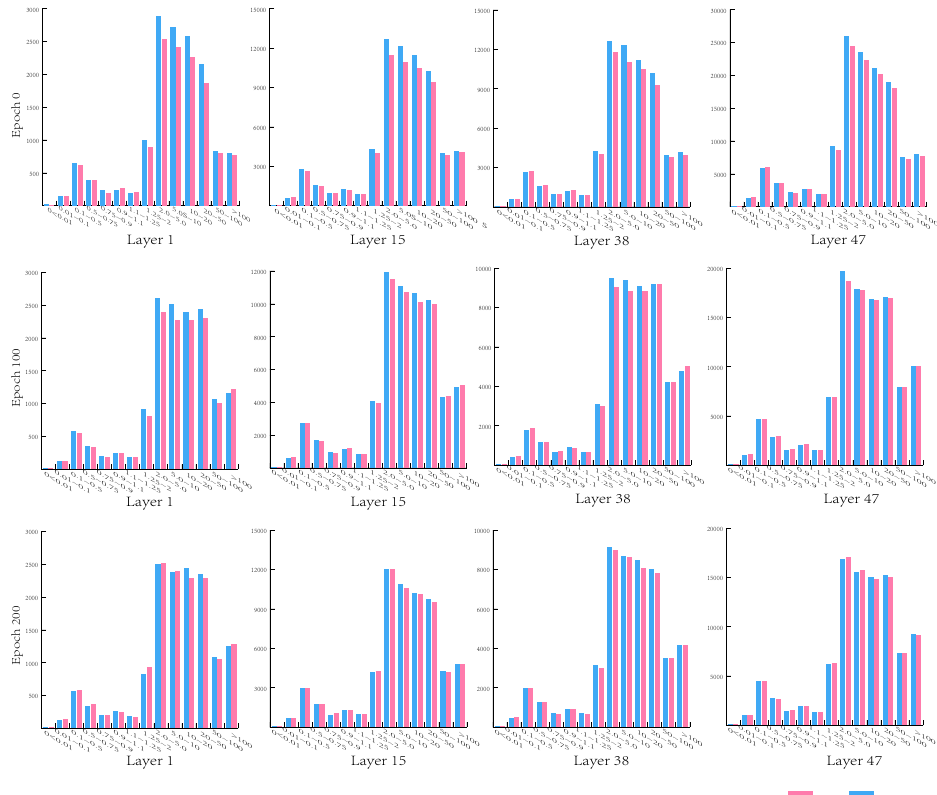
Figure 3. Sub-gradient distribution of semantic segmentation and disparity estimation. The data are gathered from 500 backpropagations of different layers in ResNet50 [2] of different epochs. The x -axis denotes the sub-gradient ratio which is the gradient of disparity: gradient of segmentation. In addition, the y -axis denotes the numbers of the ratio. ’Positive’ and ’Negative’ denote the sign of the value of ratio equation, and positive indicates the two sub-gradient in the same direction and negative indicates the opposite direction. The value of the x -axis indicates the scale of the difference of the two sub-gradients, 100 denotes that the gradient of disparity is 100 times of segmentation’s and 0.01 denotes 0.01 times. Hence, to some extent, the values of 100 and 0.01 are